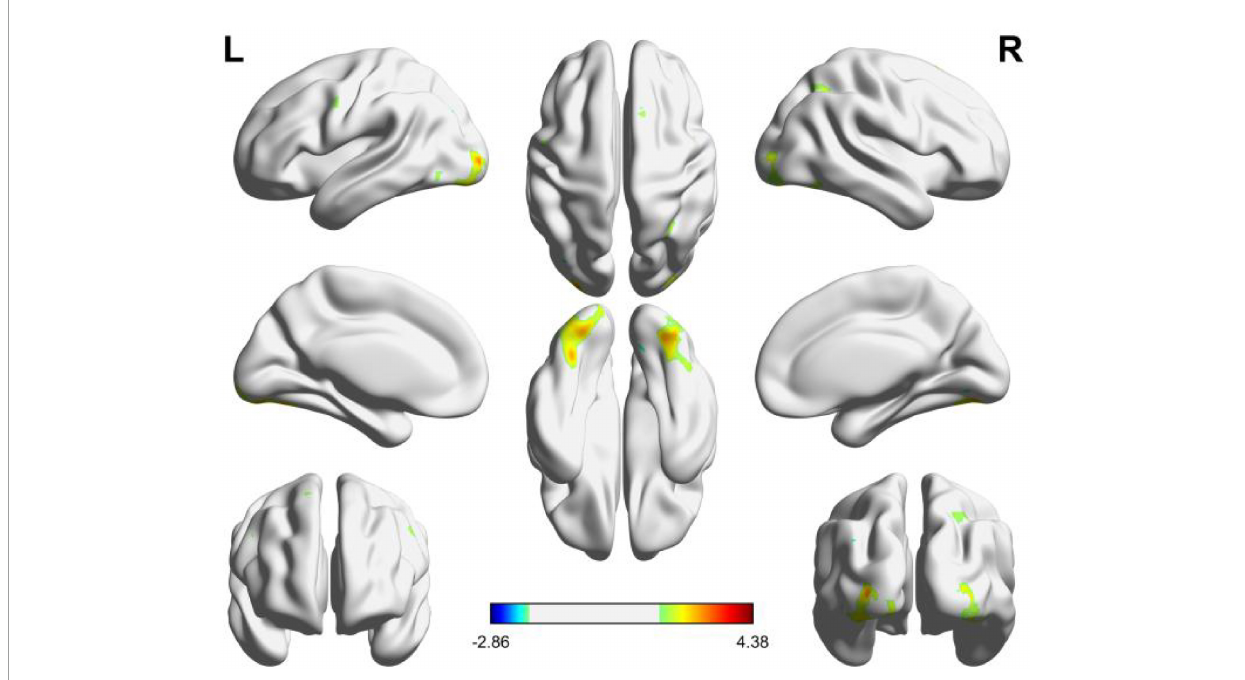
FIGURE3 Brain functional areas activated by circular shapes. The color bar indicates the size of the activation intensity. The values indicate positive or negative activation.